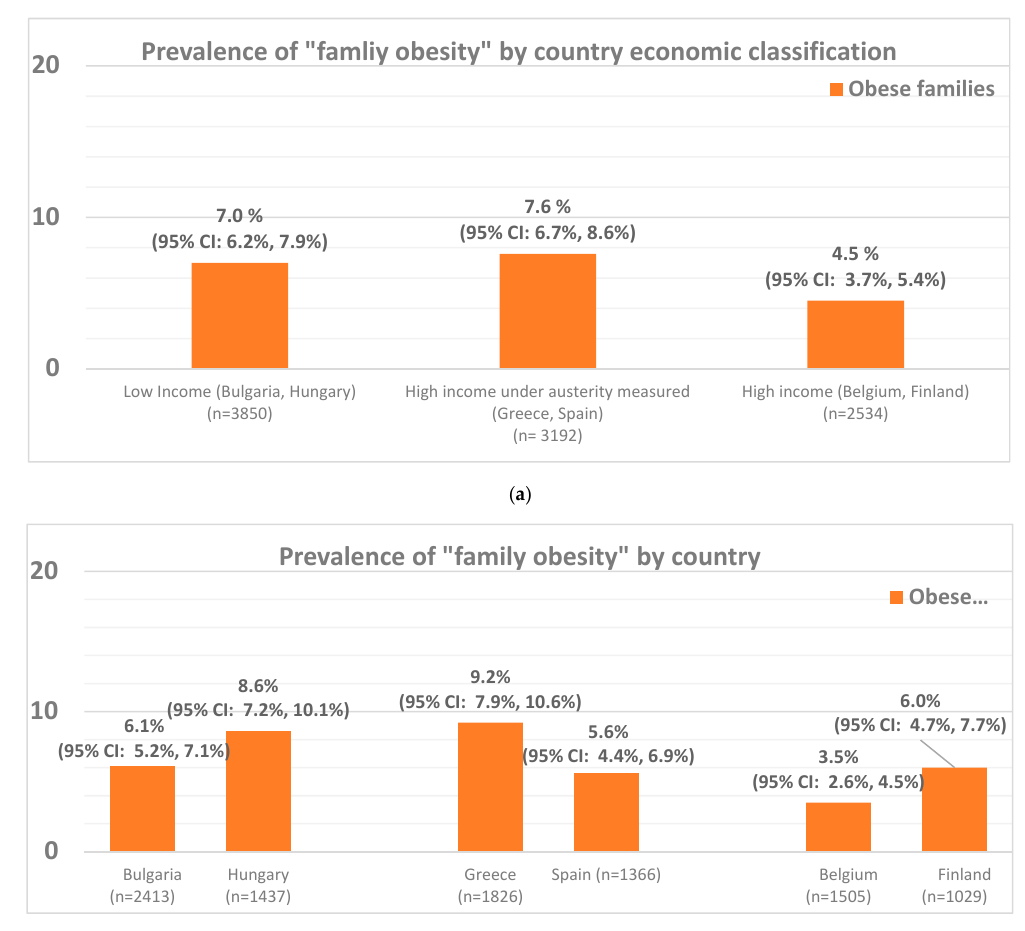
Figure 2. Prevalence of family obesity in the total sample, by country’s economic classification ( a ) and by country ( b ). p -value derived from χ 2 test. Percentages that share the same superscript letter are statistically significantly different ( p < 0.05) according to pairwise comparisons between coun- tries and economic classification of countries. Countries classified in three economic categories at the time the data were collected, as “low-income” (Bulgaria and Hungary), “high-income, under austerity measures” (Greece and Spain), and “high-income” (Belgium and Finland). Family obesity was defined as the presence of obesity in at least two out of the three family members participating in the Feel4Diabetes study (i.e., both parents or the child and any of the two parents).